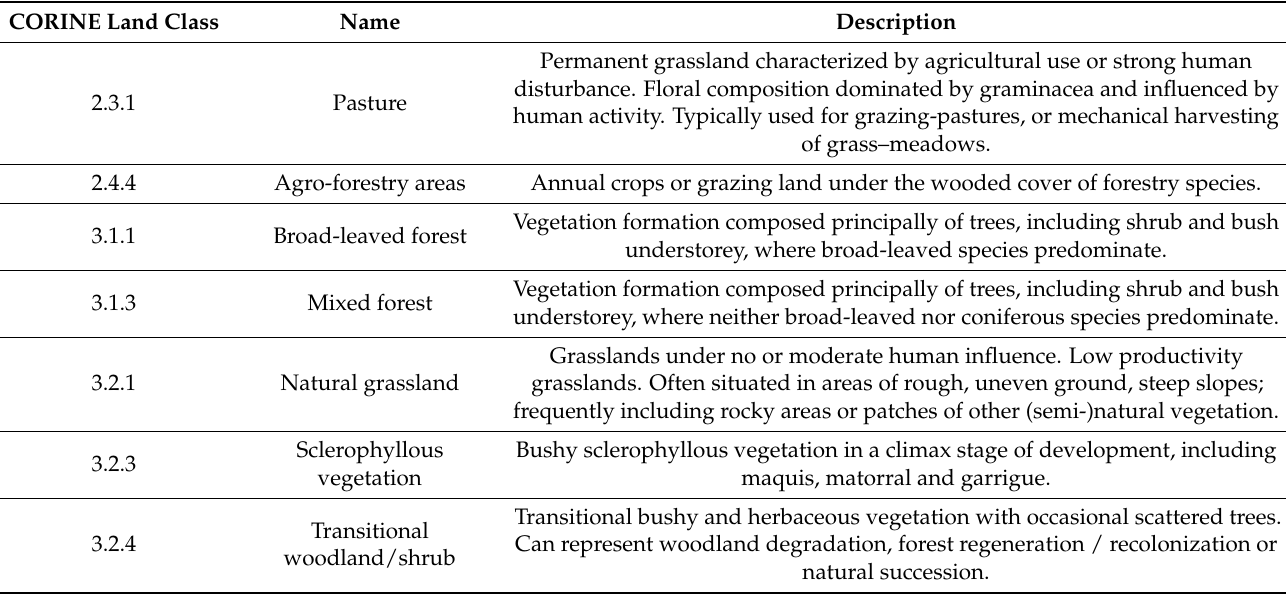
Table 1. Potential CORINE land cover classes [57] suitable for livestock grazing used in this study. CORINE Land